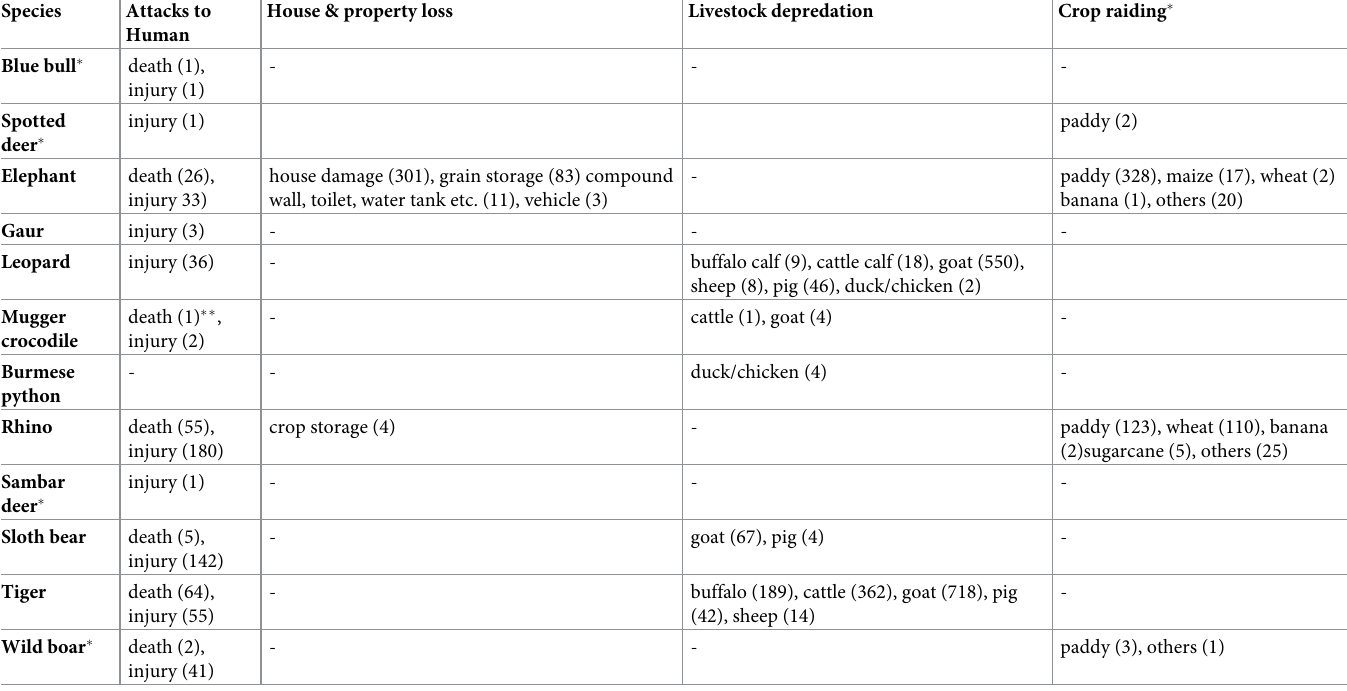
Table 1. Types of loss caused by wildlife in buffer zone of Chitwan National Park. Number in the parenthesis indicates the frequency of reported cases of the incident caused by the particular wildlife species. Species Attacks to House & property loss Livestock depredation Crop raiding Human